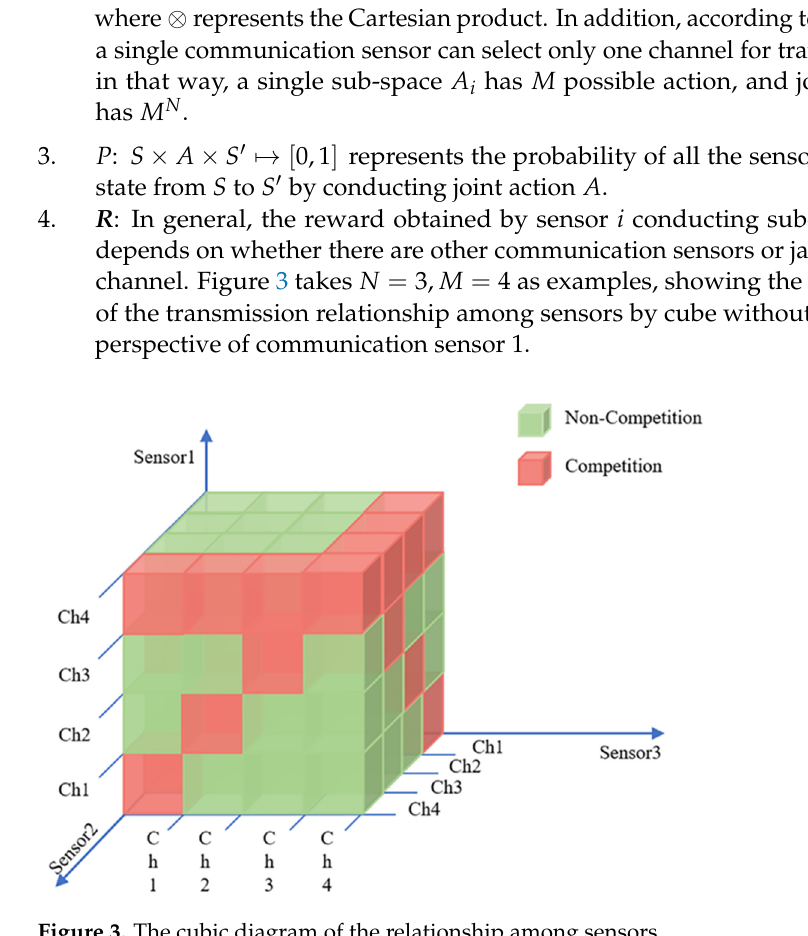
Figure 3. The cubic diagram of the relationship among sensors. As shown in Figure 3, three sensors constitute three coordinate axes of three-dimensional space, respectively, and the serial number of channels is the scale of each coordinate axis. From the perspective of sensor 1, the green cube indicates that there is no channel competition with other sensors, so the reward of successful transmission r 1 ( s , a 1 )